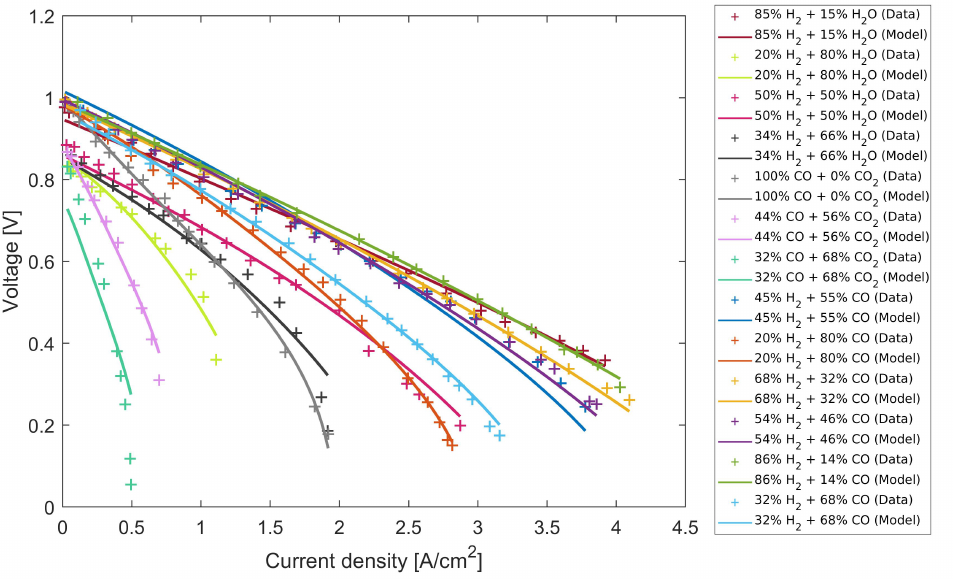
Figure 1. Results of the calibrated model with a single set of calibration parameter values for multiple polarisation